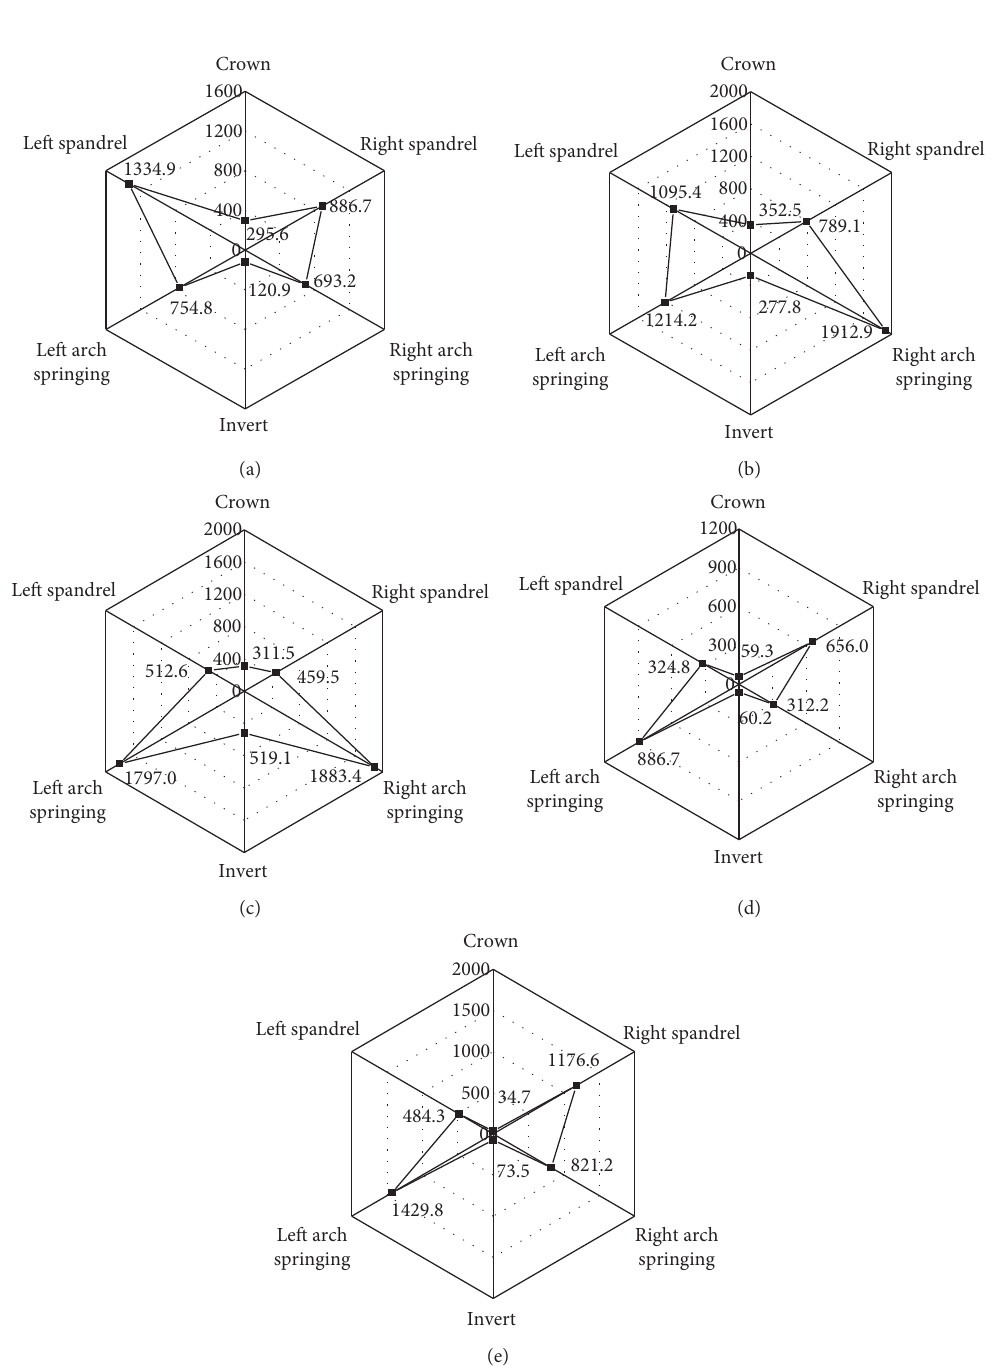
Figure 4: Peak elastic strain energy diagrams of tunnel structures with different ratios of width to height (unit: J). (a) 0.68; (b) 0.76; (c) 0.92; (d) 1.33; (e)